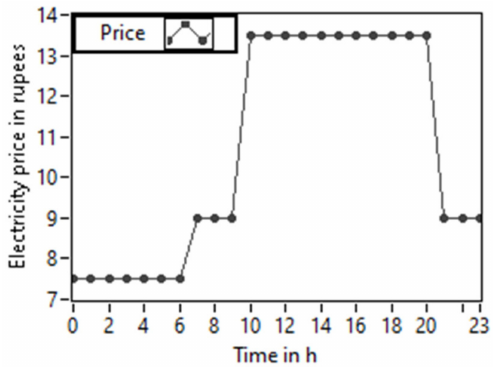
Figure 17. Time of use pricing.